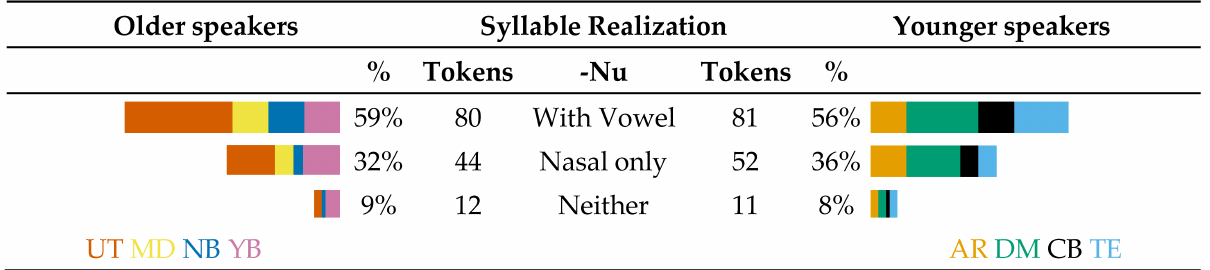
Figure 6. Realization of past tense suffixes by Older and Younger speakers. Colors refer to individual speakers, ordered youngest to oldest, left to